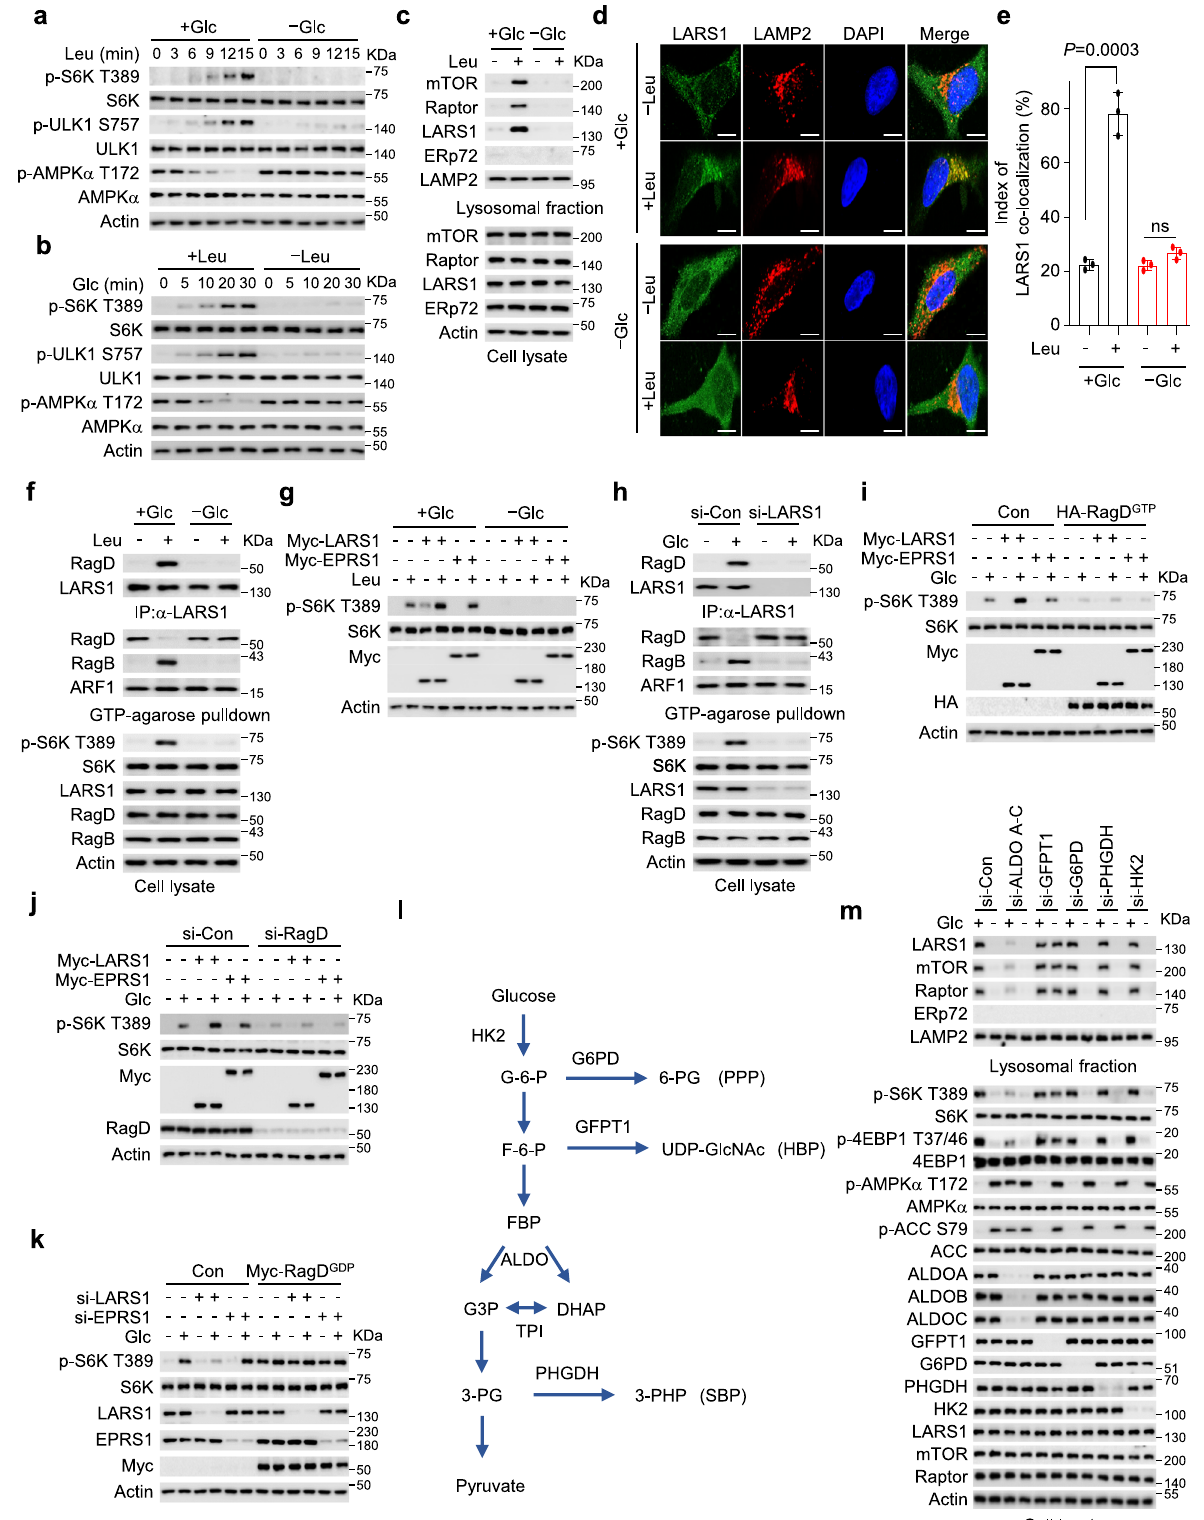
marker LAMP2 in cells. We found that the supplementation with both leucine and glucose induced the lysosomal localization of LARS1, whereas the leucine-induced lysosomal localization of LARS1 was not observed in glucose-starved cells (Fig. 1d,